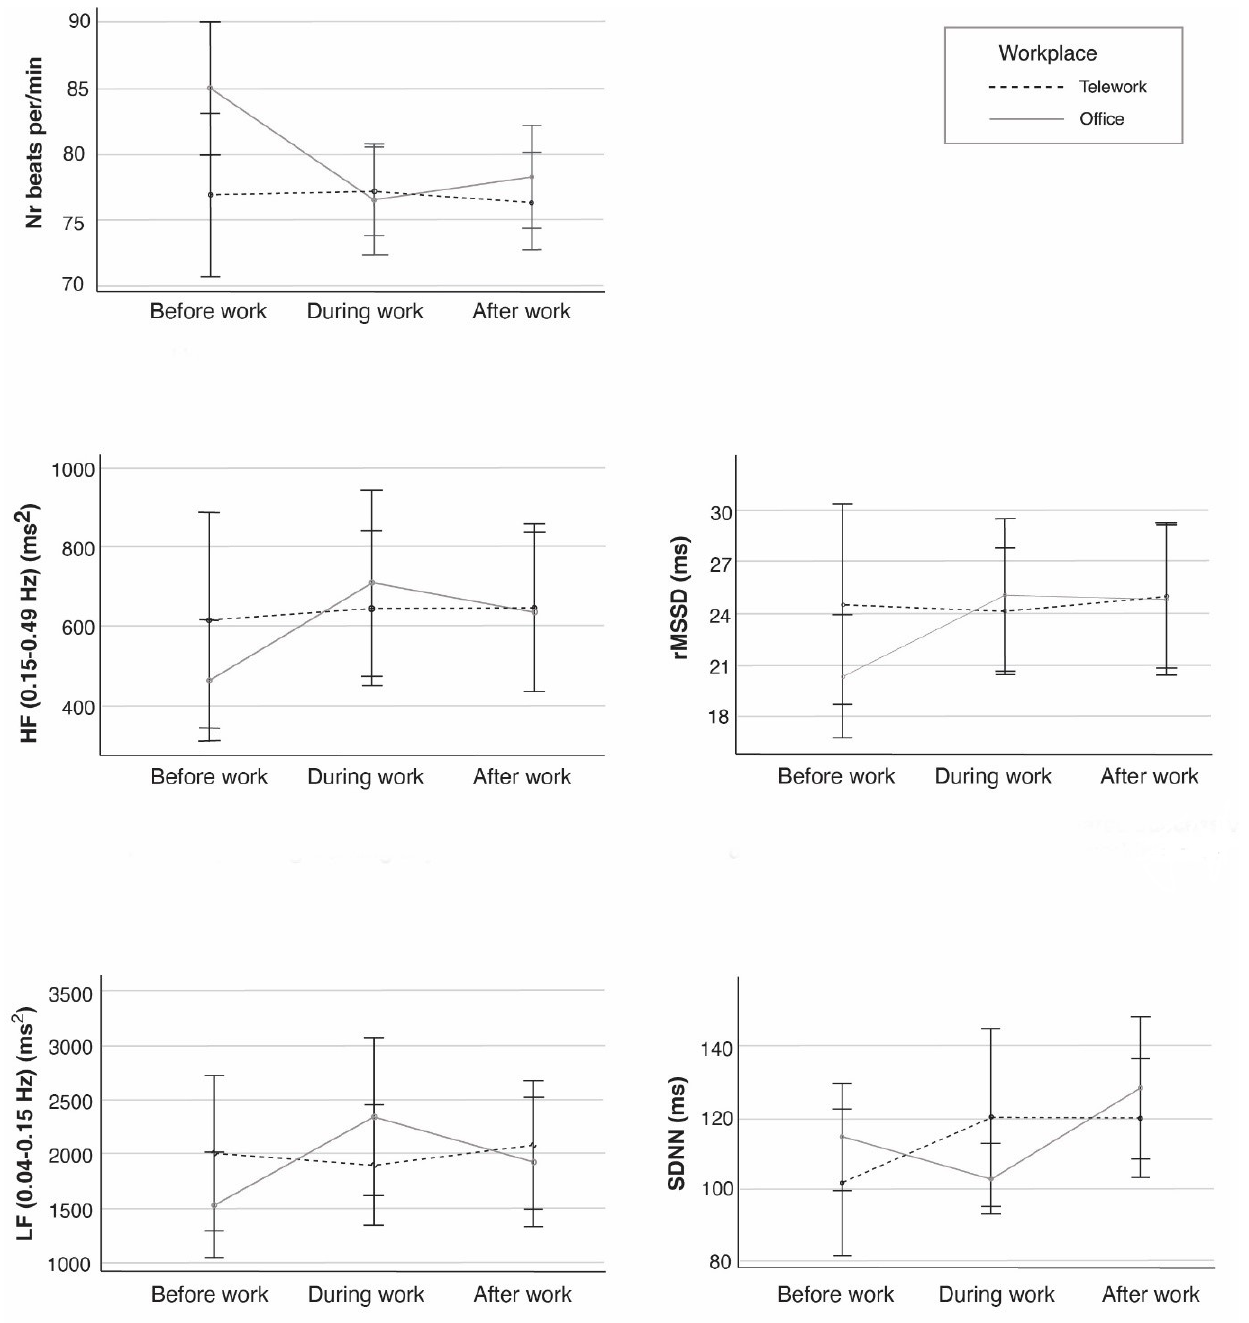
Figure 2. Estimated marginal means of Workplace (telework; office) and Time (leisure time before work; work during regular workhours; leisure time after work) from the repeated measure analysis of variance with heart rate (number of beats per minute) and heart rate variability indices: HF: high frequency (0.15–0.40 Hz) (ms 2 ); LF: low frequency (0.04–0.15 Hz) (ms 2 ); SDNN: the standard deviation of beat-to-beat intervals (ms); rMSSD (1 min intervals): the root mean squared successive differences of RRI (ms) ( n = 20). Error bars represent 95% confidence interval.